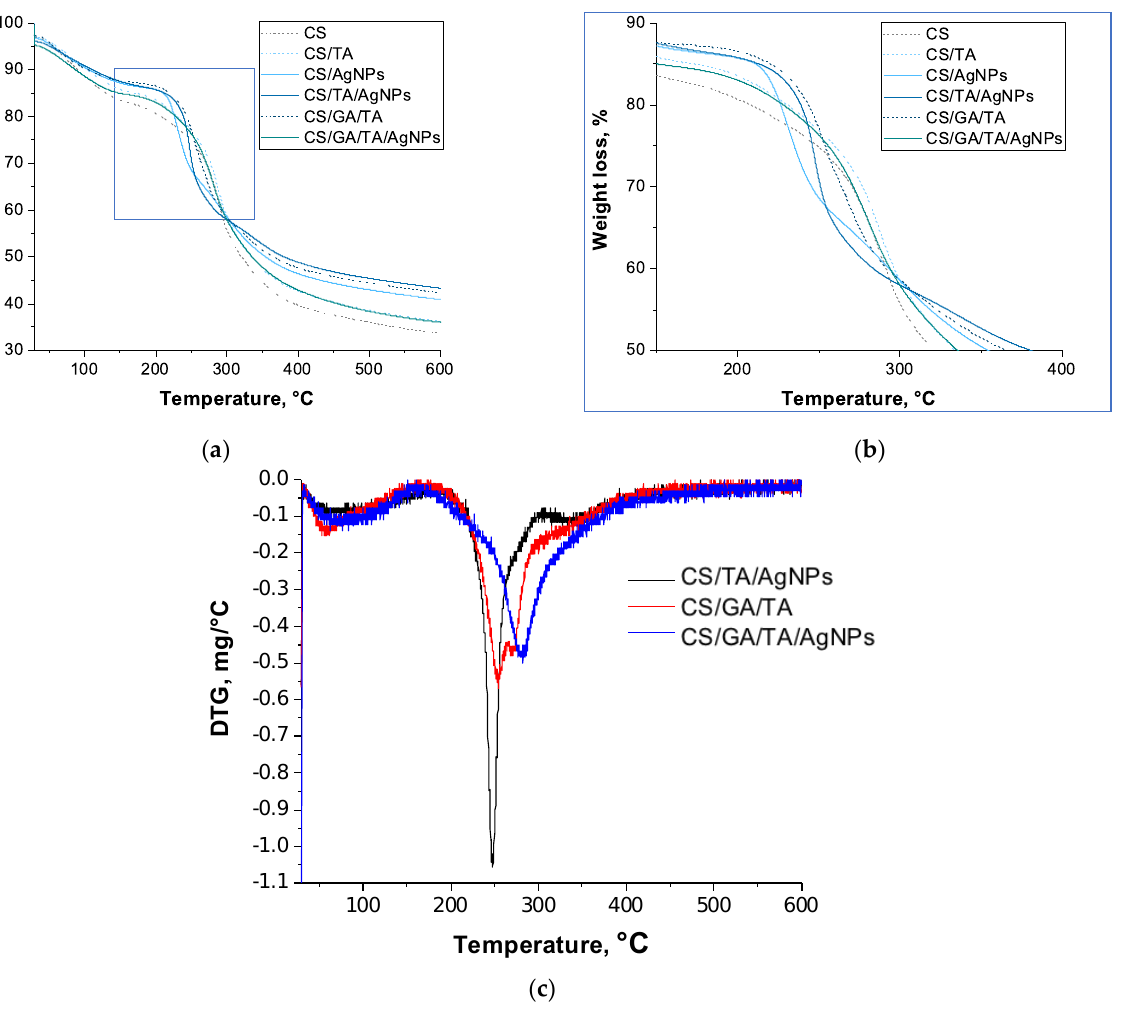
Figure 7. ( a ) Thermogravimetric analysis (TGA) curves, ( b ) zoom of the area highlighted in blue in the former panel and ( c ) first derivative of weight loss curves (DTG) of composite films.